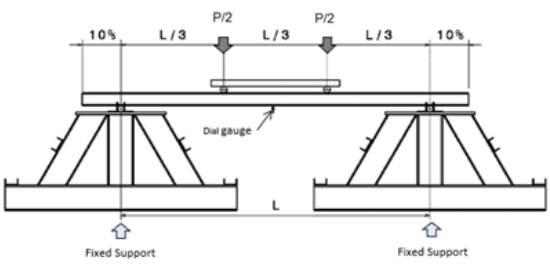
Fig. 6. Testing rig setup.